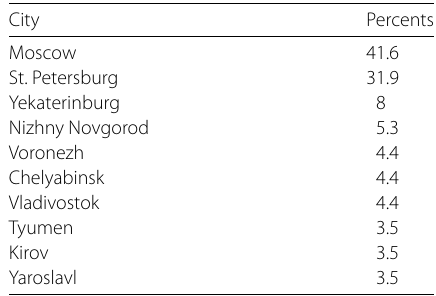
Table 13 Distribution of the most common cities identified in the final dataset